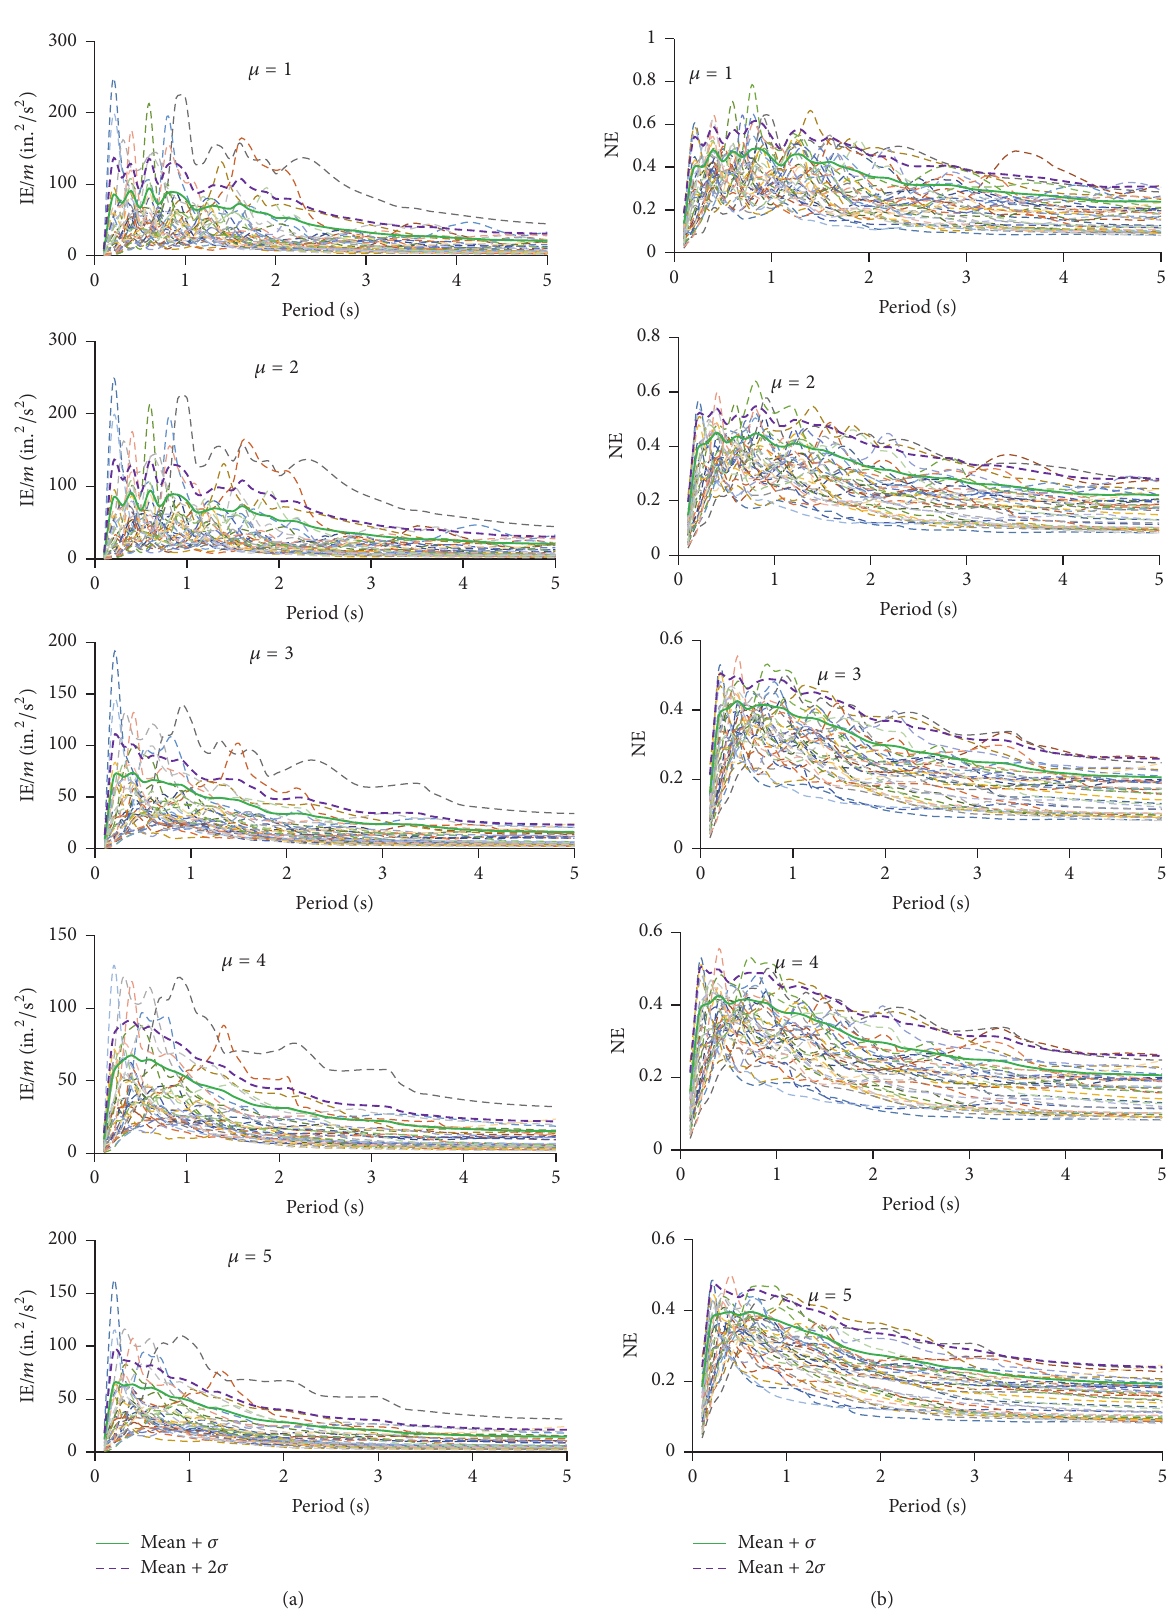
Figure 4: Comparison of actual (IE /𝑚 ) and VI normalized input energy (NE)